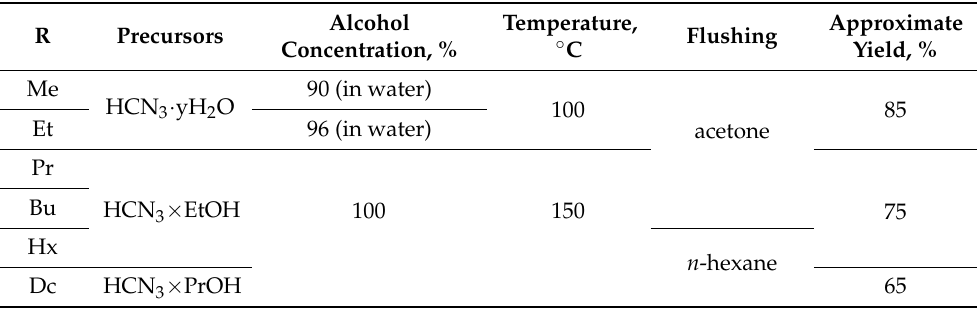
Table 3. Conditions for the synthesis of n -alkoxy derivatives HCN 3 × ROH. In all cases, the reaction time was 7